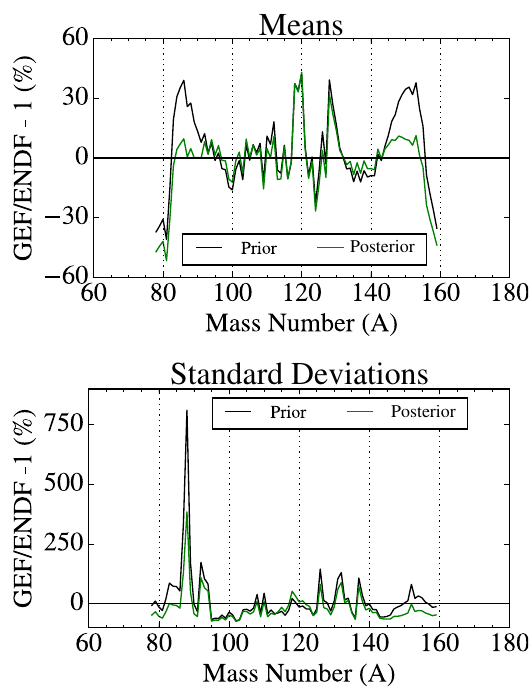
Figure 3. Relative di ff erences between ENDF / B-VIII.0 and GEF of the means and standard deviations of the independent FY data for